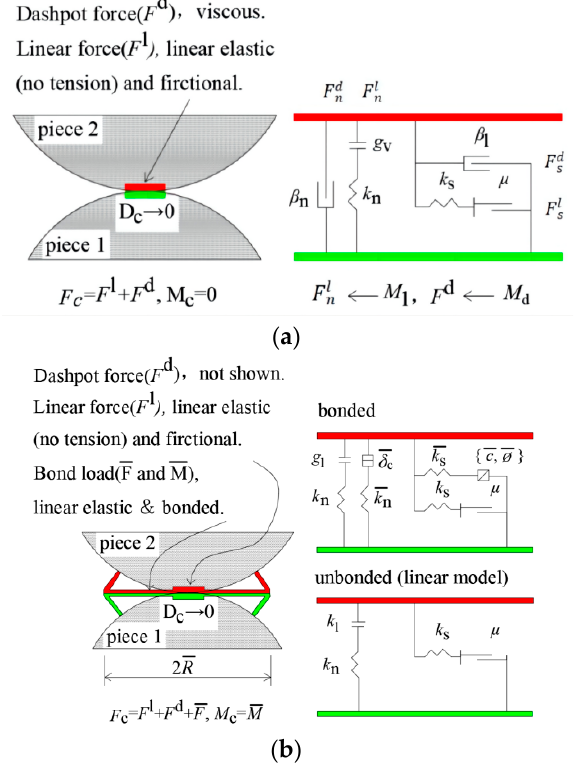
Figure 6. Illustration of the model used in this research [27]. ( a ) the illustration of the linear model; ( b ) the connection between two different particles is controlled by the linear parallel bond model.